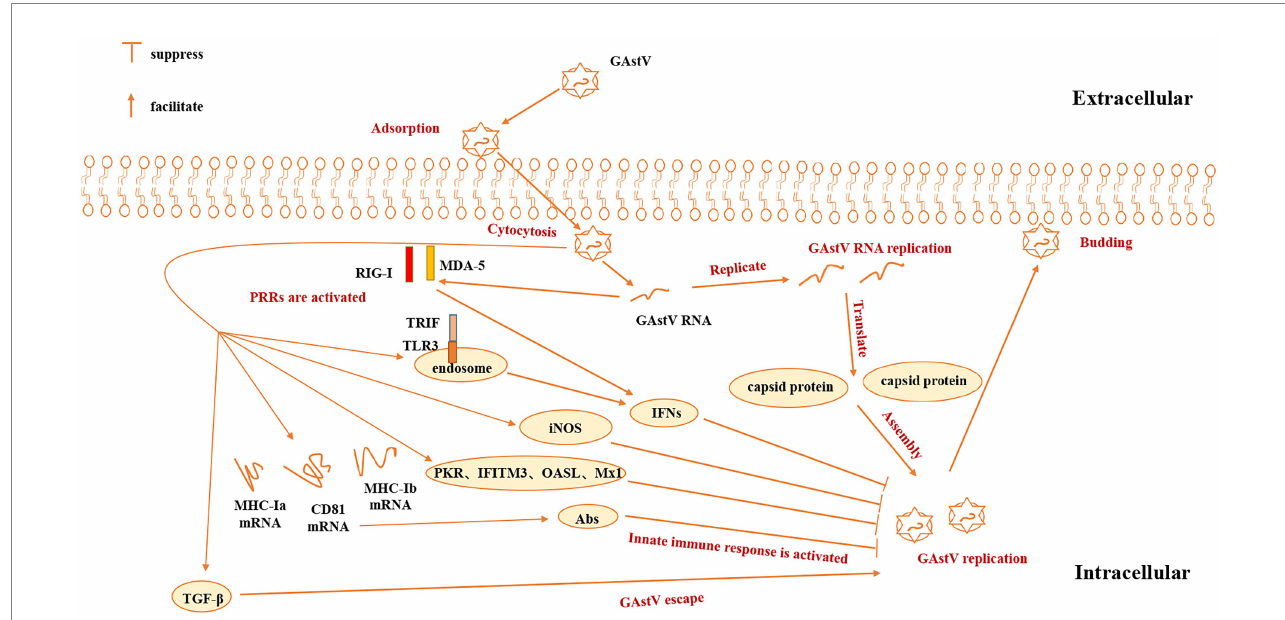
FIGURE 4 Innate immune mechanism of goose astrovirus. GAstV, goose astrovirus; PRRs, pattern recognition receptors; PKR, IFITM3, OASL, Mx1, antiviral proteins; RIG-I, MDA-5, TLR-3; pattern recognition receptors; Abs, antibodies; TGF- β , transforming growth factor- β ; iNOS, inducible nitric oxide